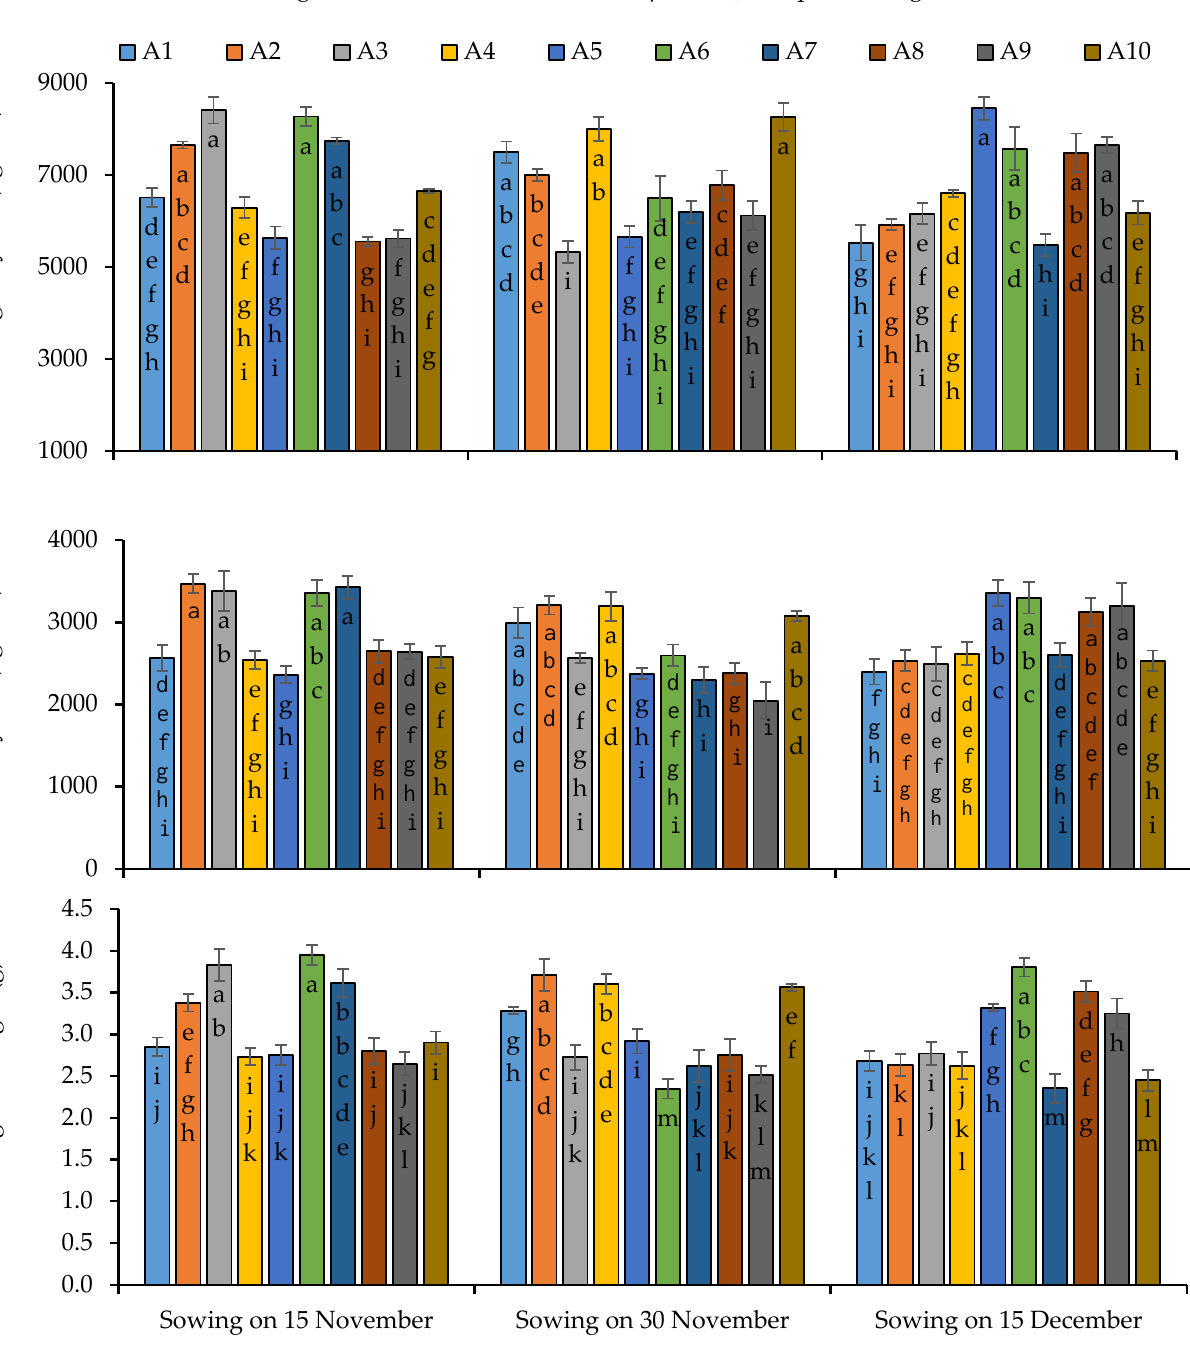
Figure 6. Biological yield, grain yield and thousand grain weight of quinoa lines grown under varying sowing dates. Bars sharing the same alphabet did not differ significantly at p < 0.05. Small alphabets (a, b, c. etc.) are used to express the statistically significant difference.